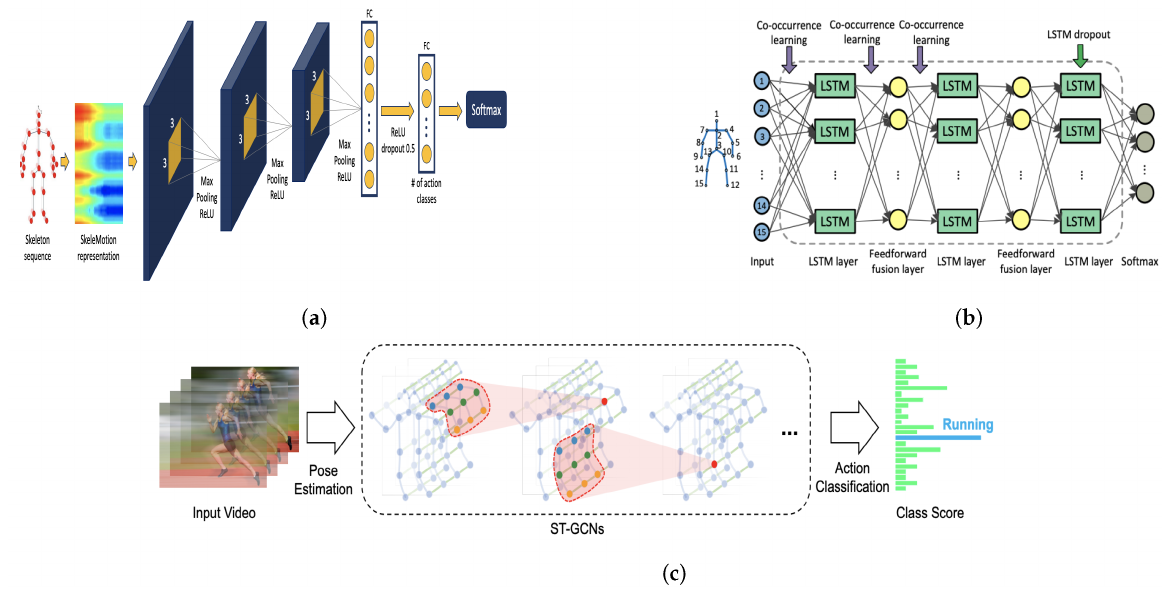
Figure 5. Illustration of deep learning techniques for processing RGB-D data. ( a ) Convolutional Neural Network (CNN). ( b ) Long Short-Term Memory (LSTM). ( c ) Graph Convolutional Network